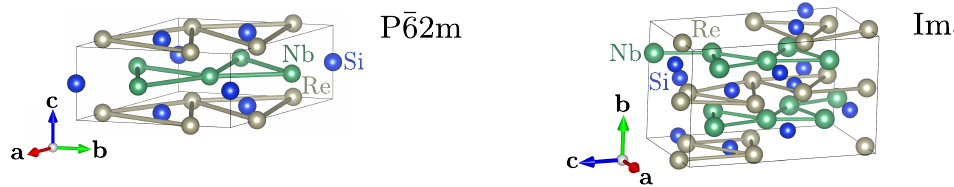
Figure 1. Schematic representation of NbReSi conventional cell with P¯62m and Ima2 symmetries (as labeled). In both structures, the Re and Nb atoms form distorted kagome-like